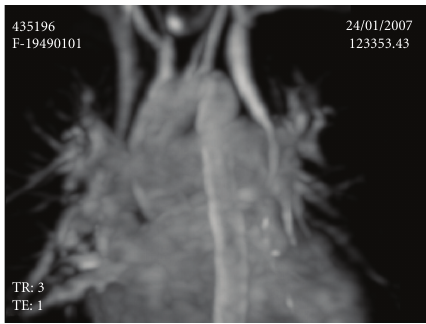
Figure 2: MRI showing 2 superior vena cavas, one on the right and the other on the left